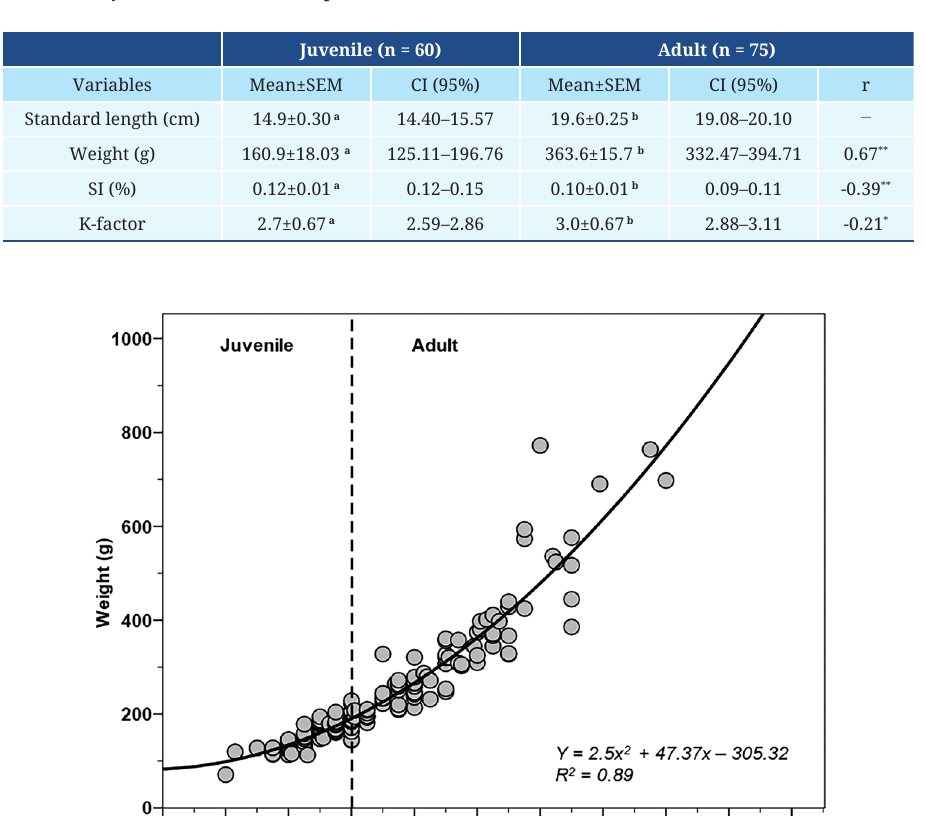
TABLE 1 | Biometrical variables according to age in Pygocentrus nattereri and linear correlation (Pearson’s model, r) with standard-length. Distinct letters represent a significant difference (P < 0.05); SEM = standard error of mean; CI = confidence interval; r = Pearson´s correlation coefficient; K = Fulton’s body condition factor; SI = splenosomatic index; **P < 0.01; *P <